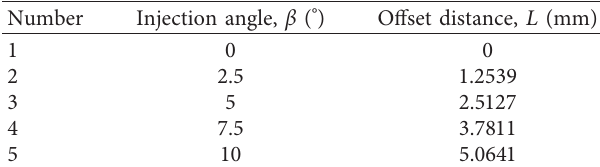
Table 2: Nozzle layout parameters.